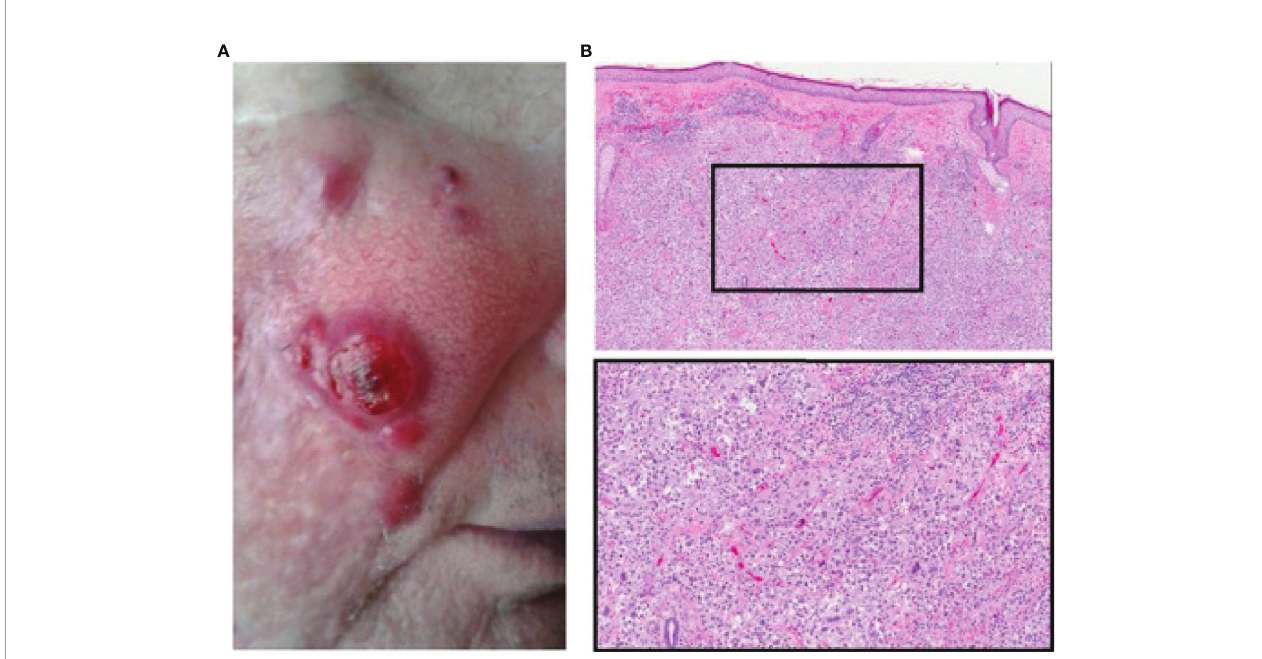
FIGURE 1 | Pre-treatment recurrence of facial cSCC. (A) Extent of disease on the right cheek prior to starting treatment with intra-lesional IL-2. (B) Histological pro fi le of facial lesions prior to starting intra-lesional IL2 (top 40X, bottom 100X magni fi cation), showing poorly differentiated